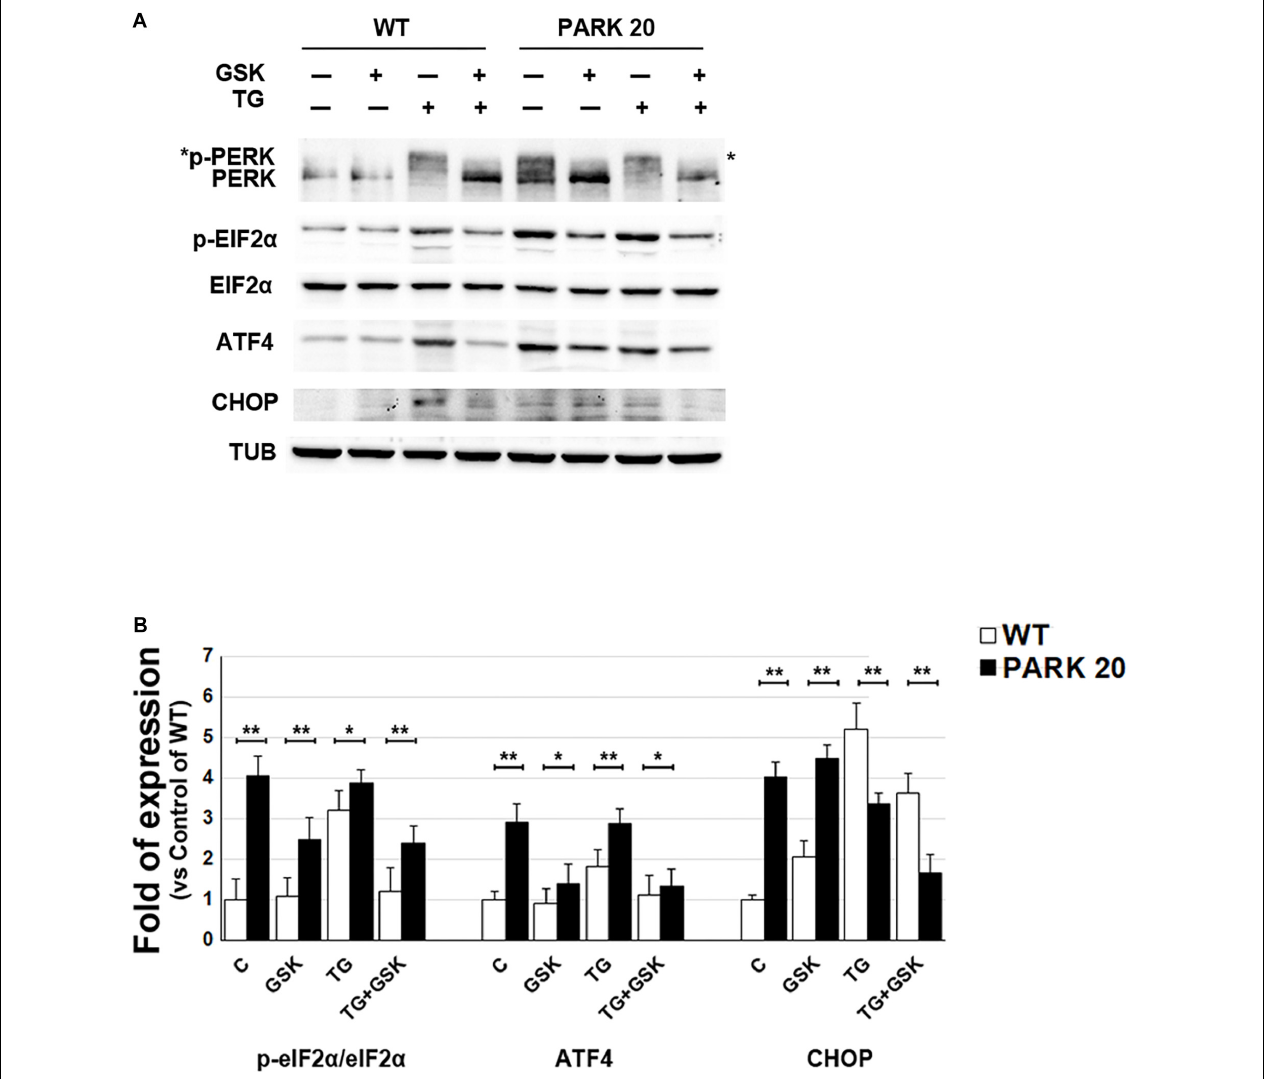
FIGURE 4 | The PERK-dependent pathway of the UPR is up-regulated in PARK20 fibroblasts. (A,B) Western blot analysis of the relative expression of markers of the PERK-dependent pathway of UPR. Starved HDF (WT) and PARK20 cells were either untreated (C) or treated for 2 h with 1 µ M GSK2606414 (GSK) or 500 nM Thapsigargin (TG) alone (GSK and TG respectively) or in combination (TG + GSK). For TG + GSK samples, a pre-treatment of 30 min with GSK2606414 was performed prior to the addition of TG. α -Tubulin (TUB) was used as loading control. (B) Densitometry analyses of three independent experiments are shown. Histogram shows the relative fold induction of the expression of the indicated proteins in the treated samples compared to the control samples. Results are expressed as mean values ± SD; ∗ p ≤ 0.05, ∗∗ p ≤ 0.01, Student’s t -test.